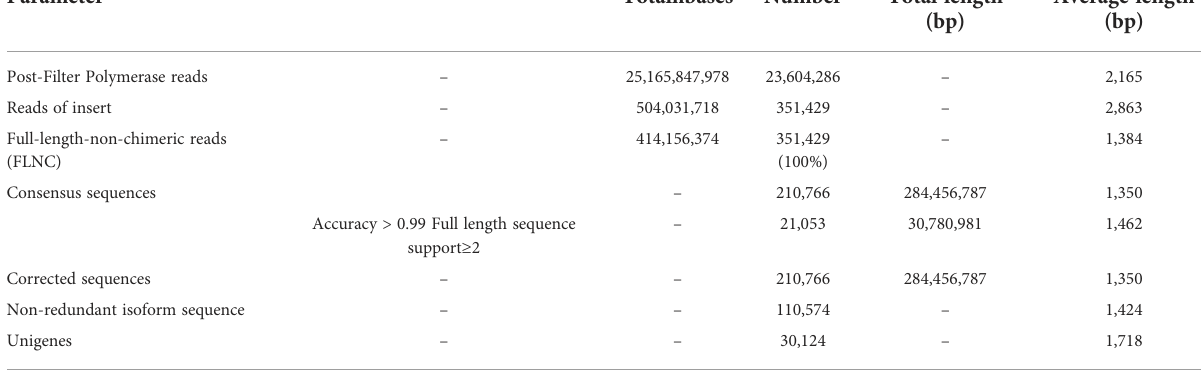
TABLE 2 Statistics of transcriptome sequencing and assembly for the